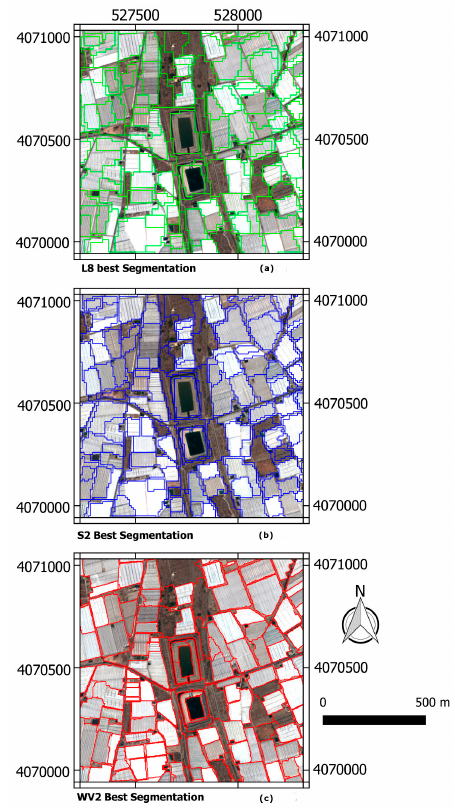
Figure 3. Visual comparison of the best achieved segmentations over the WorldView-2 orthoimage (true colour visualization): ( a ) Landsat 8; ( b ) Sentinel-2; ( c ) WorldView-2. Coordinate system: ETRS89 UTM Zone 30N.